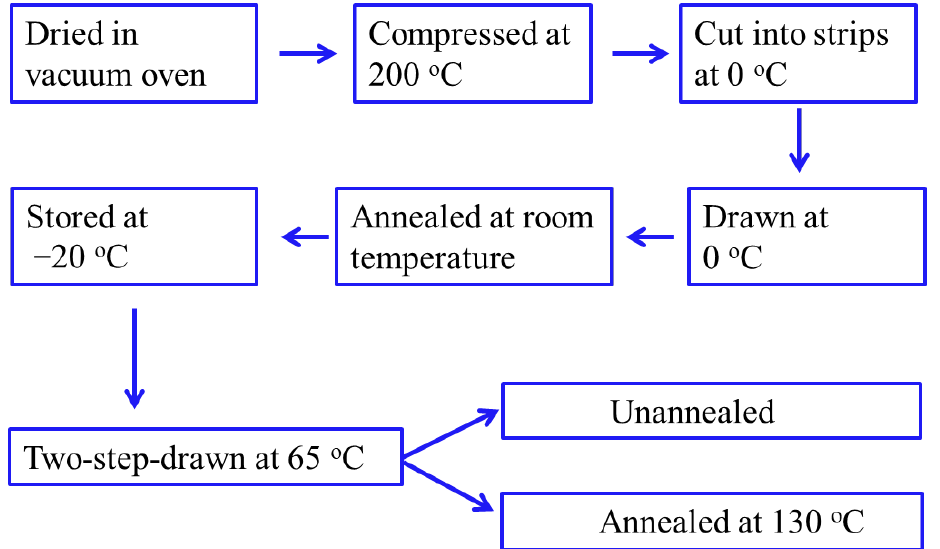
Figure 1. Part of the homemade stretching machine with a water